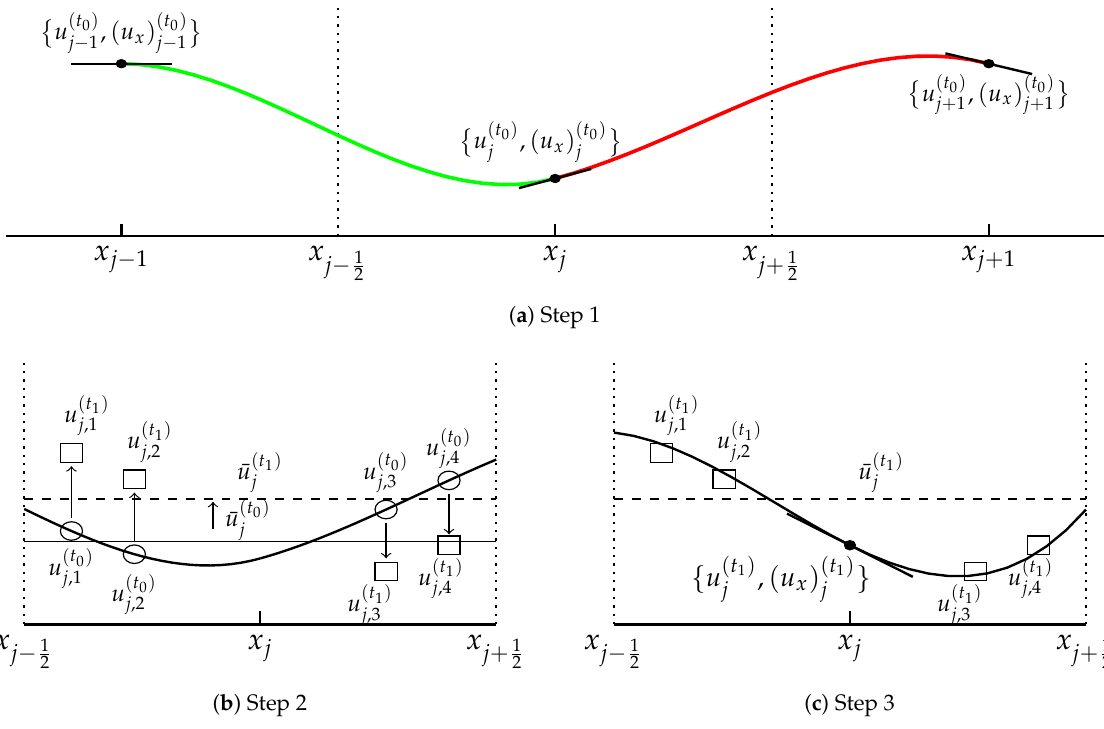
Figure 1. Algorithm